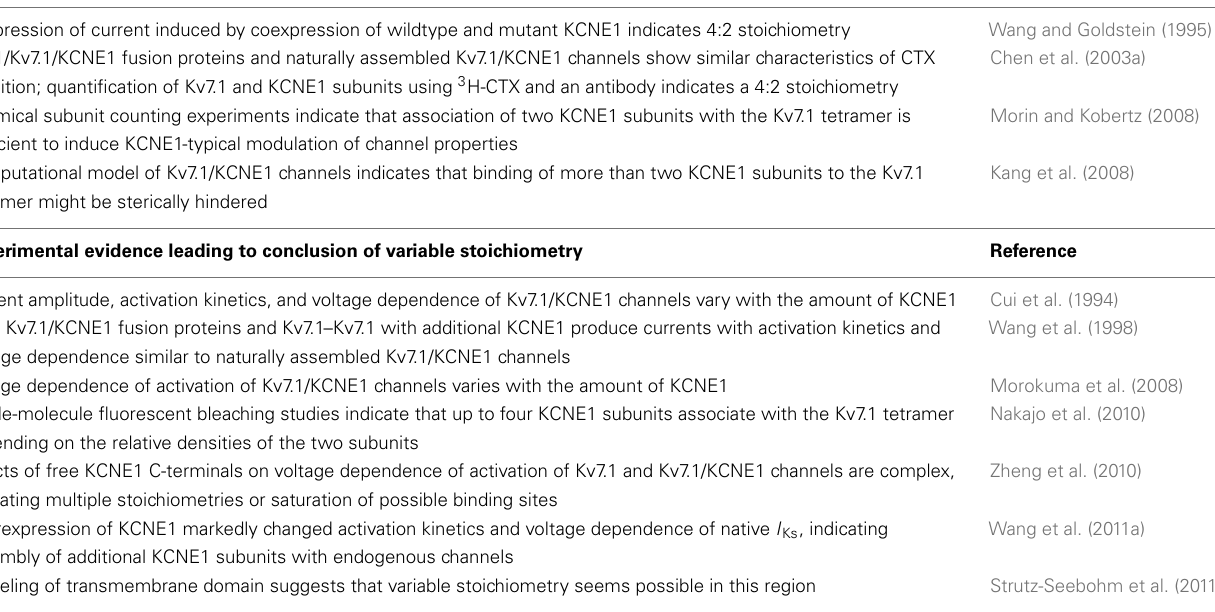
Table 2 ; Franqueza et al., 1999; Chouabe et al., 2000; Chen et